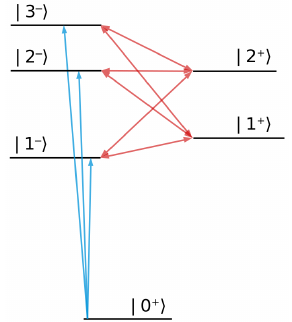
Figure 2. Level structure of the few-level atom employed to illustrate ATA spectroscopy. XUV transitions from the ground state are shown in blue. Red arrows indicate laser dressing of the excited states. The superscripts represent the parity of each state.